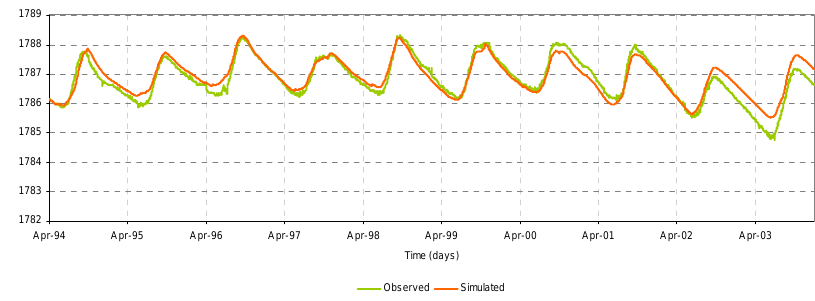
Figure 7: Comparison of simulated to observed lake levels Fig. 7. Comparison of simulated to observed lake